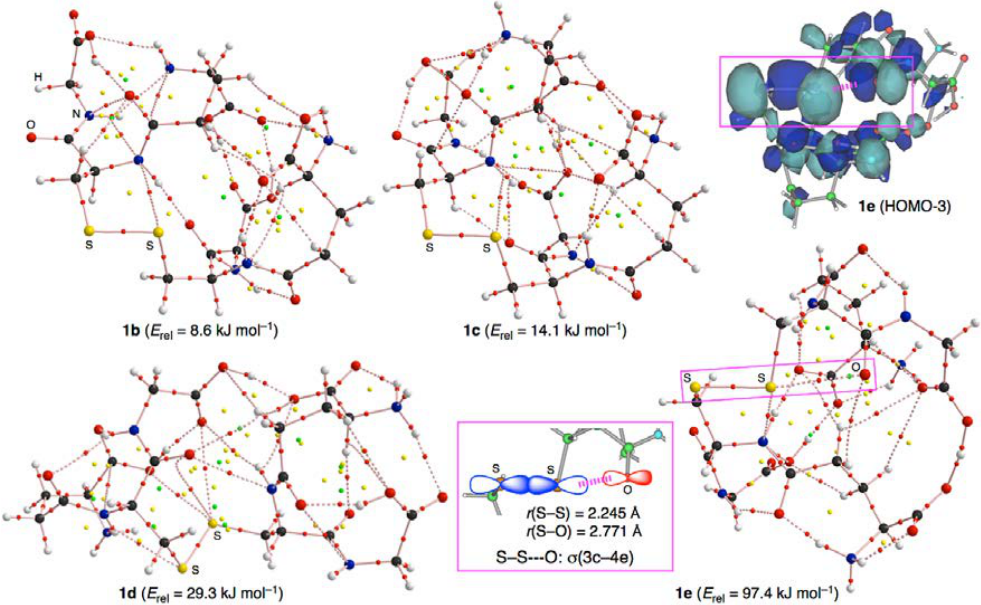
Figure 4. Molecular graphs of 1b – 1e , drawn on the optimized structures and the molecular orbital of HOMO-3 for 1e with the orbital interaction map explaining the HOMO-3.